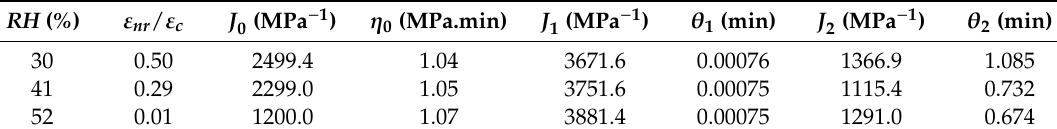
Table 2. Generalized Kelvin-Voigt model parameters.